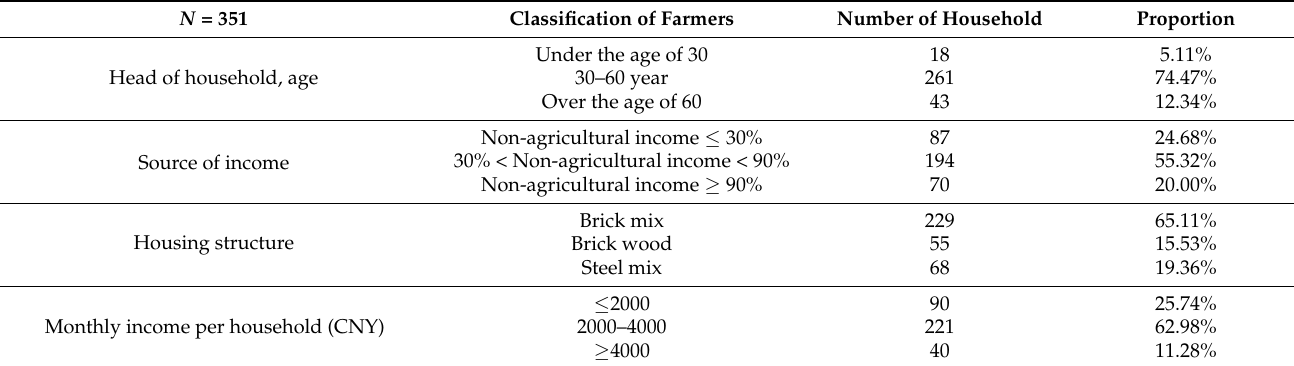
Table 2. Basic feature descriptive analysis of the